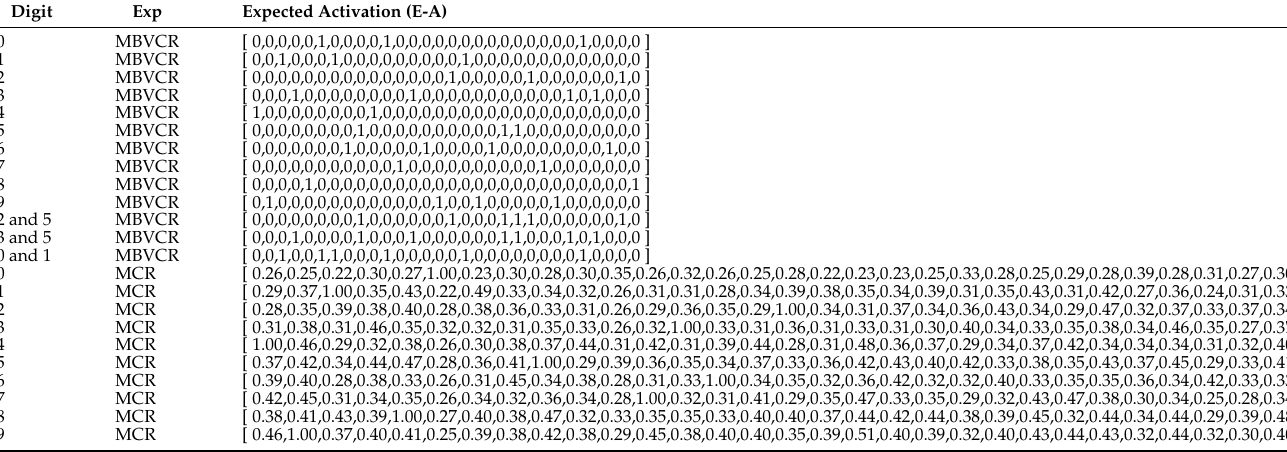
Table 5. Expected activation injected at thirty convex abstract concept (CAC) nodes in layer 1 of RAN model for MNIST